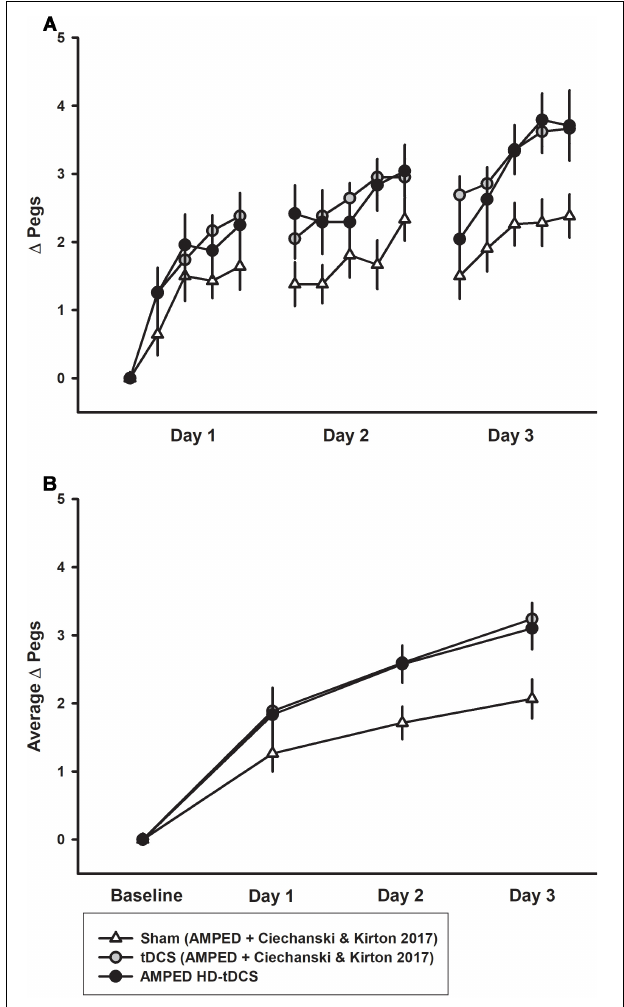
FIGURE 6 | Combined PPT L training data for sham and tDCS groups over 3 days. (A) Sham (white triangles, n = 14) learning curves were inferior to both tDCS (gray circles, n = 14) and HD-tDCS (black circles, n = 8) groups. (B) Mean daily learning for the same three groups form the combined studies. Both the tDCS and HD-tDCS groups placed more pegs each day as compared to sham.